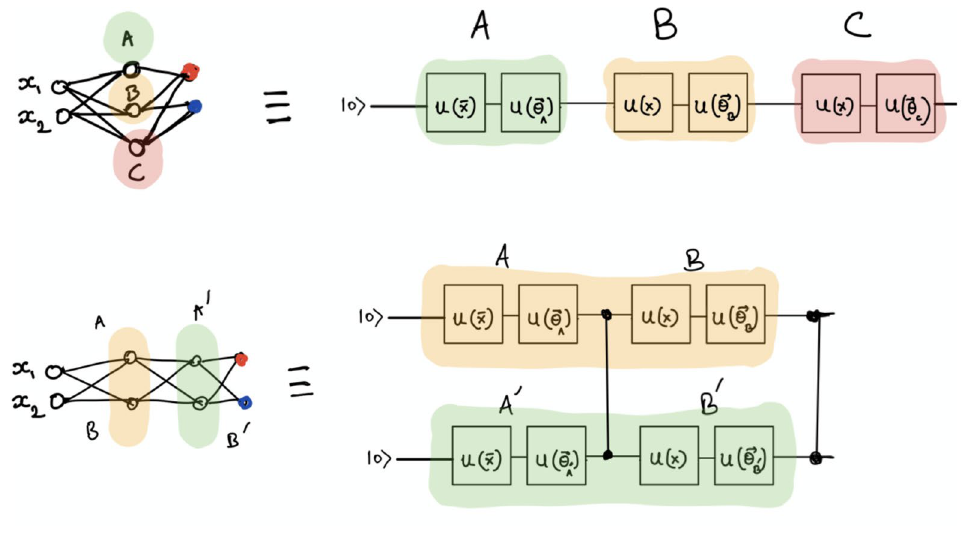
Figure 10. Quantum circuit implementing data-reuploading with strongly entangling layers, where entanglement between the blocks is introduced with controlled two-qubit gates. Figure is taken from the online source Ref. 58 .